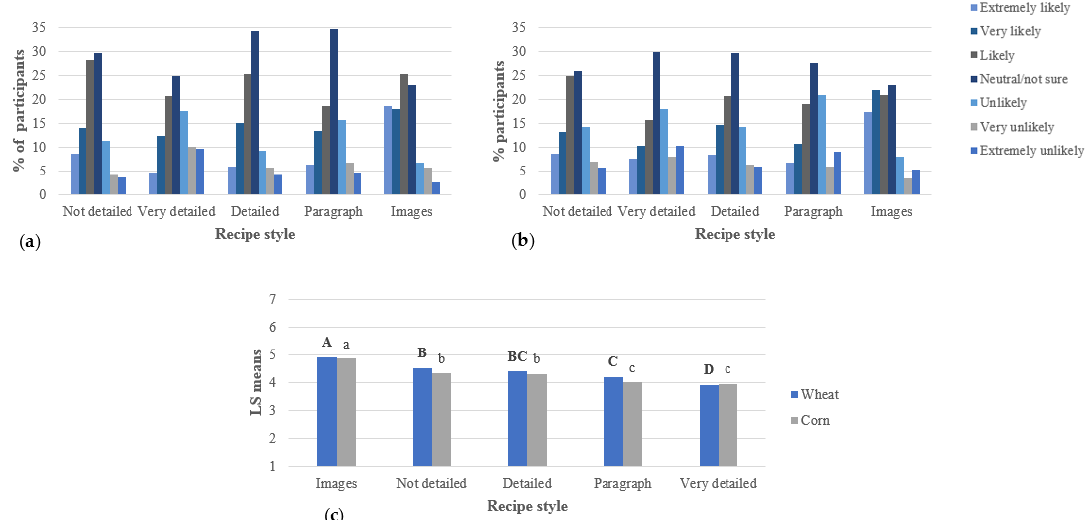
Figure 1. Easiness of the recipes presented to respondents (per study, n = 300), including ( a ) wheat study, ( b ) corn study, and ( c ) ANOVA. For the ANOVA, statistical comparisons are within wheat and corn recipes: bold, uppercase letters represent the wheat recipes; not bold, lowercase letters represent the corn recipes. Different letters among studies represent significantly different means ( p < 0.05).